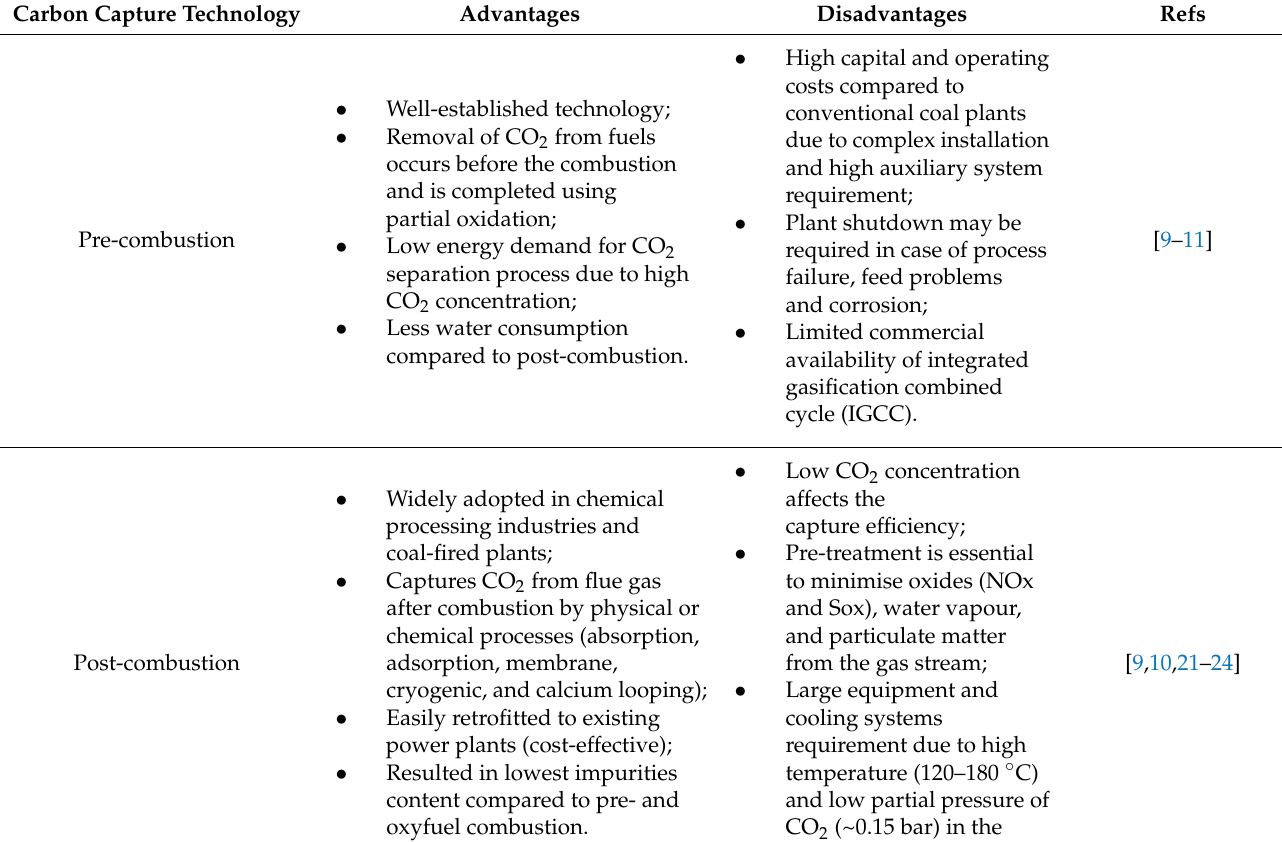
Table 1. Summary of advantages and disadvantages of various carbon capture technology. Carbon Capture